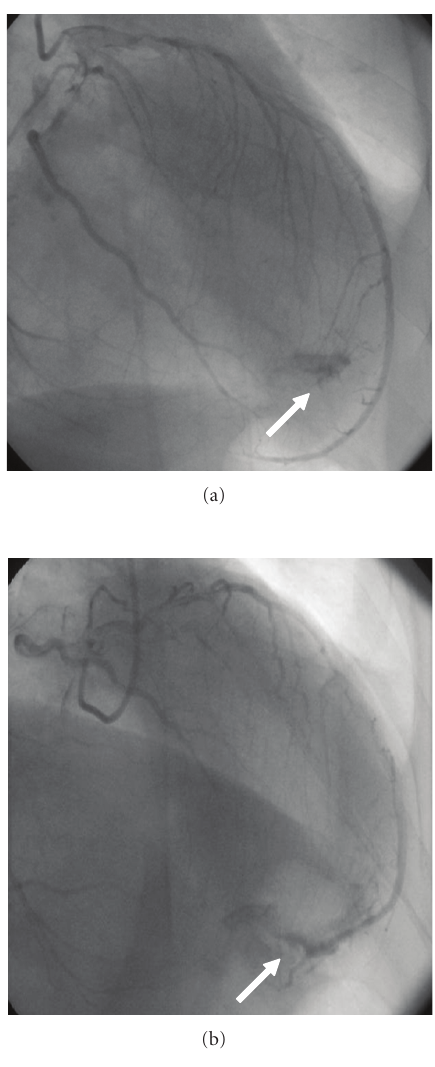
Figure 1: Figures (a) and (b) Fistula from distal of left coronary artery to the left ventricle is